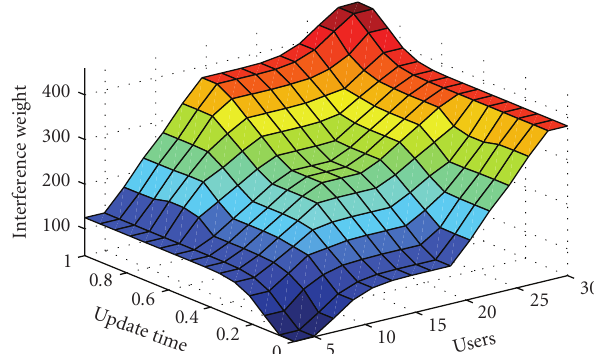
Figure 3: Interference weight as a function of the update interval and the number of users.